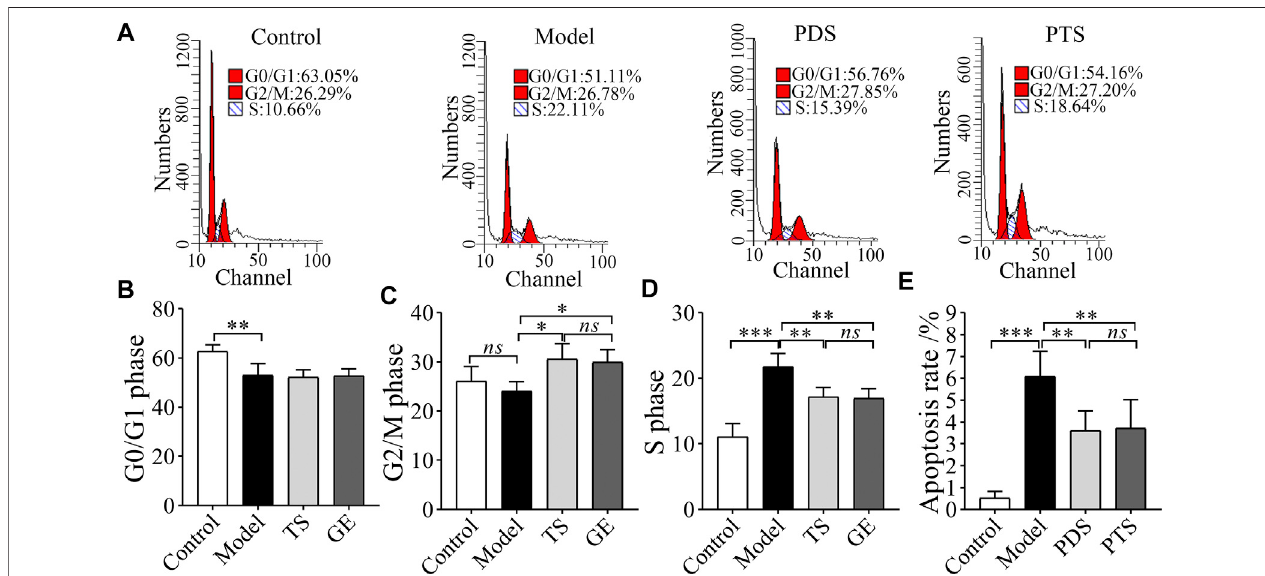
FIGURE7| TheeffectofPDSandPTSoncellcycleandtheapoptosisofbonemarrowinmyelosuppressionmice. (A) Cellcyclescatterplotofbonemarrowby fl ow cytometry. (B) analysisof G 0 /G 1 phase; (C) analysisofG 2 /M phase; (D) analysisofS phase. (E) analysis ofapoptosis rate. The dataare expressed asmean ±SD ( n = 3)